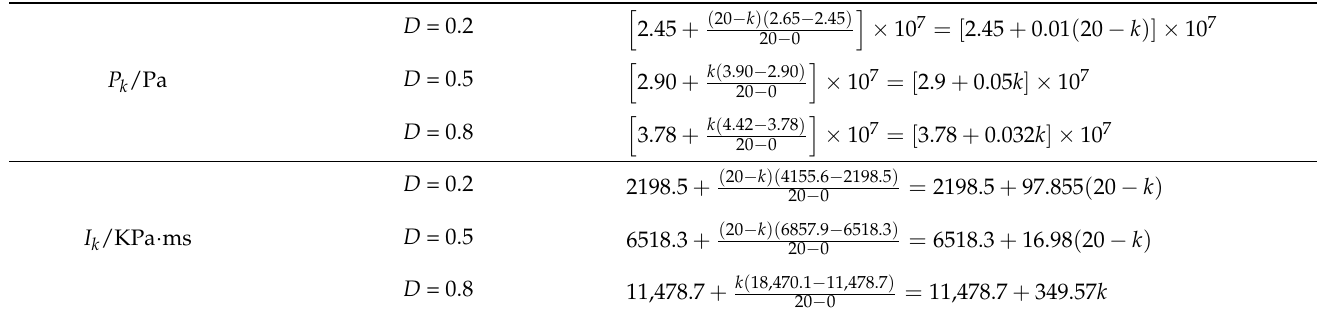
Table 7. The predicted values P k and I k under geostress of k